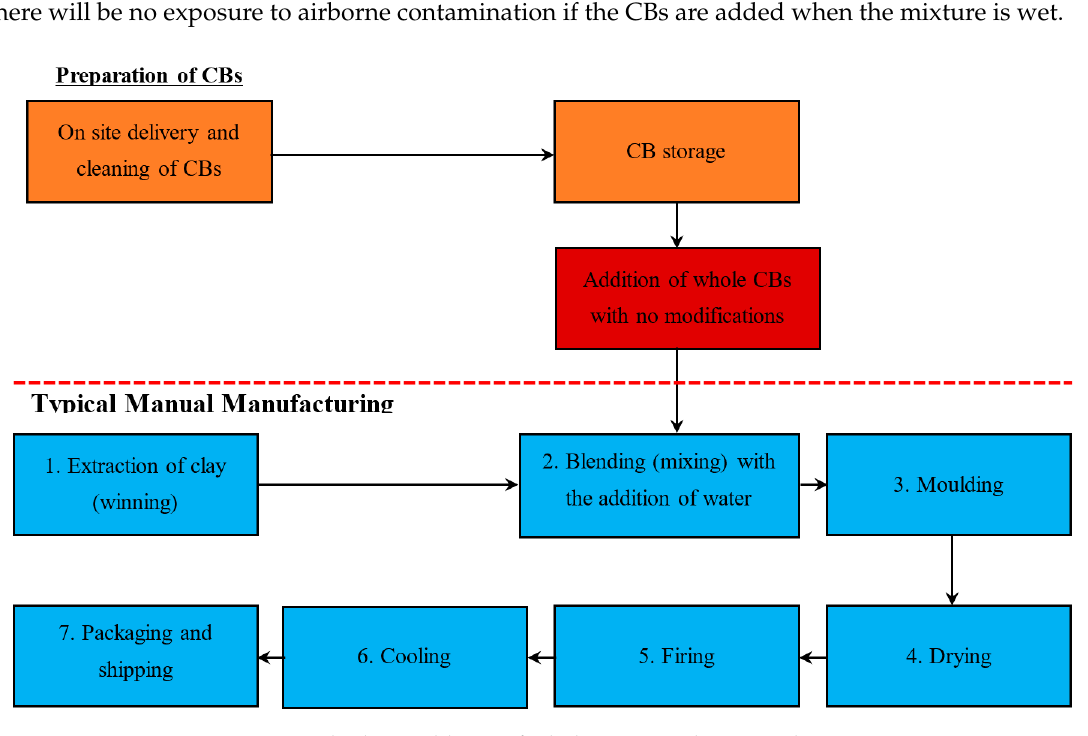
Figure 5. Method 1—Addition of whole CBs into the Manual Process.